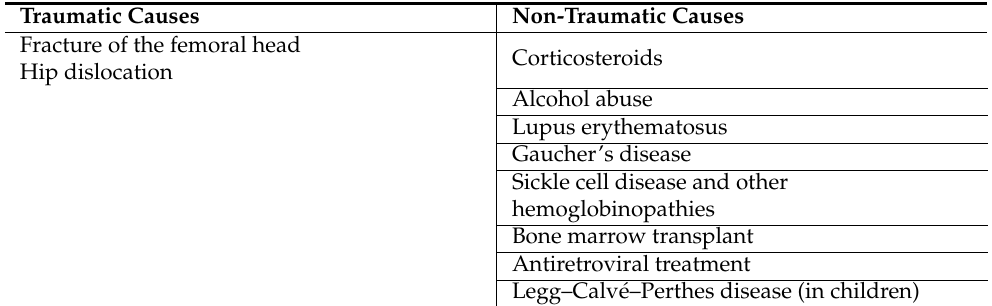
Table 1. Traumatic and non-traumatic causes of avascular necrosis of the femoral head [1,9]. Traumatic Causes Non-Traumatic Causes Fracture of the femoral head Hip dislocation